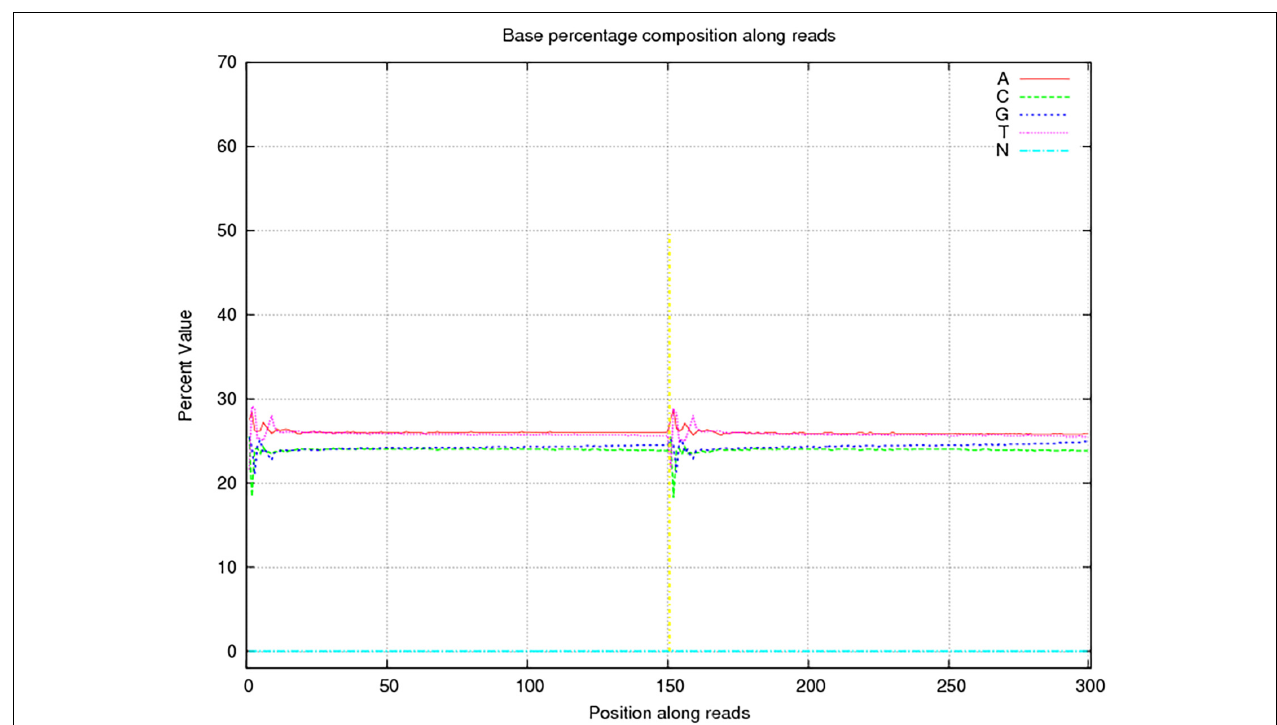
FIGURE 2 | Sequencing base percentage composition among reads. The abscissa presents the position on the reads, the ordinate presents the content of a certain base at that position, and the five colors indicate the proportions of content of the four bases of ATGC and undetected bases (Ns).